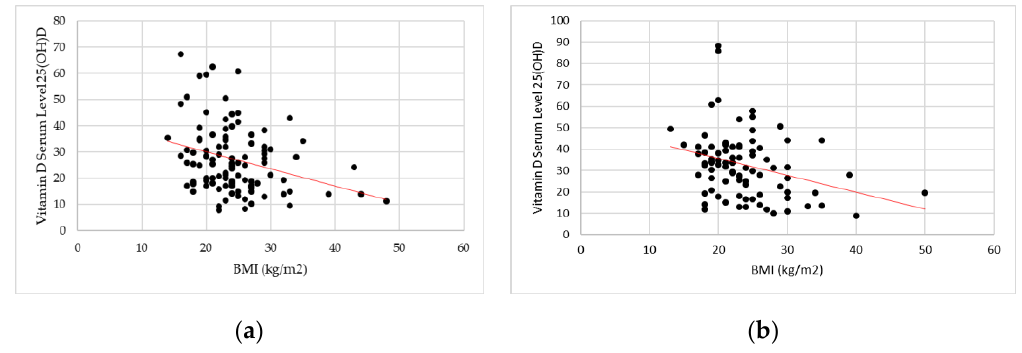
Figure 3. Scatterplot — correlation between body mass index (BMI) and vitamin D serum levels 25(OH)D: ( a ) Crohn’s disease patients; ( b ) Ulcerative Colitis patients.